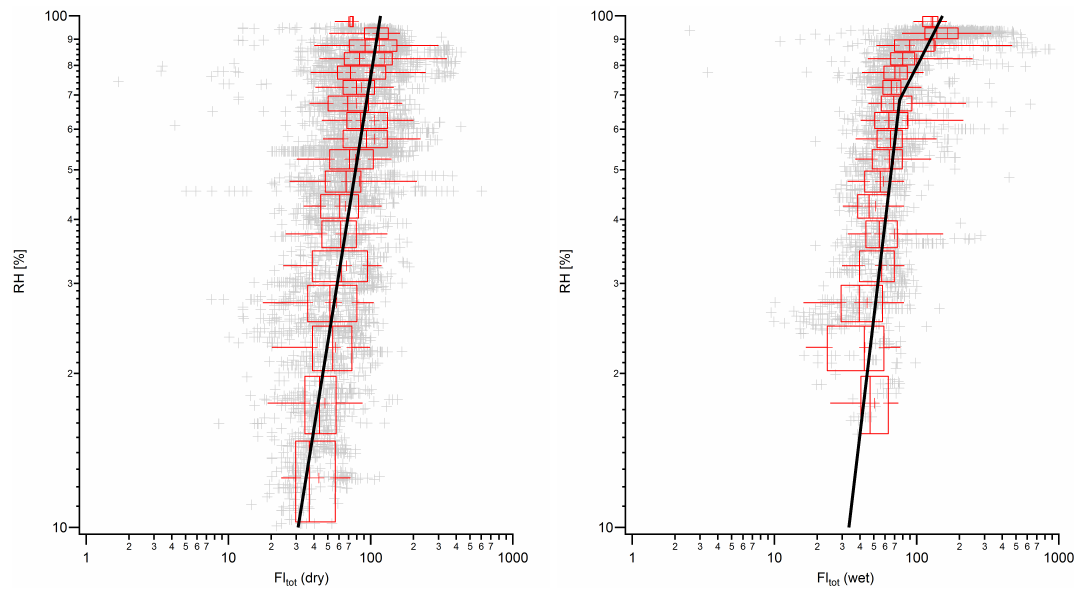
Figure 10. RH Response of total fluorescent particle number concentration, Fl tot , for dry (left) and wet (right) periods with linear fits in log–log space added (see Eqs. 1–2.) Norm of residuals: Fl tot (dry)=0.36; Fl tot (wet, RH < 70%),=0.17; Fl tot (wet, RH ≥ 70%)=0.20.